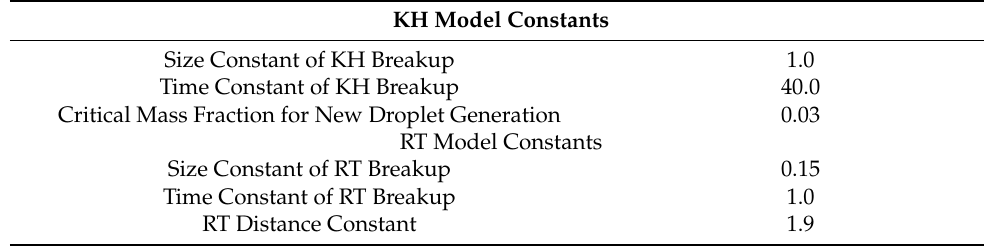
Table A1. KH/RT Setting in Forte